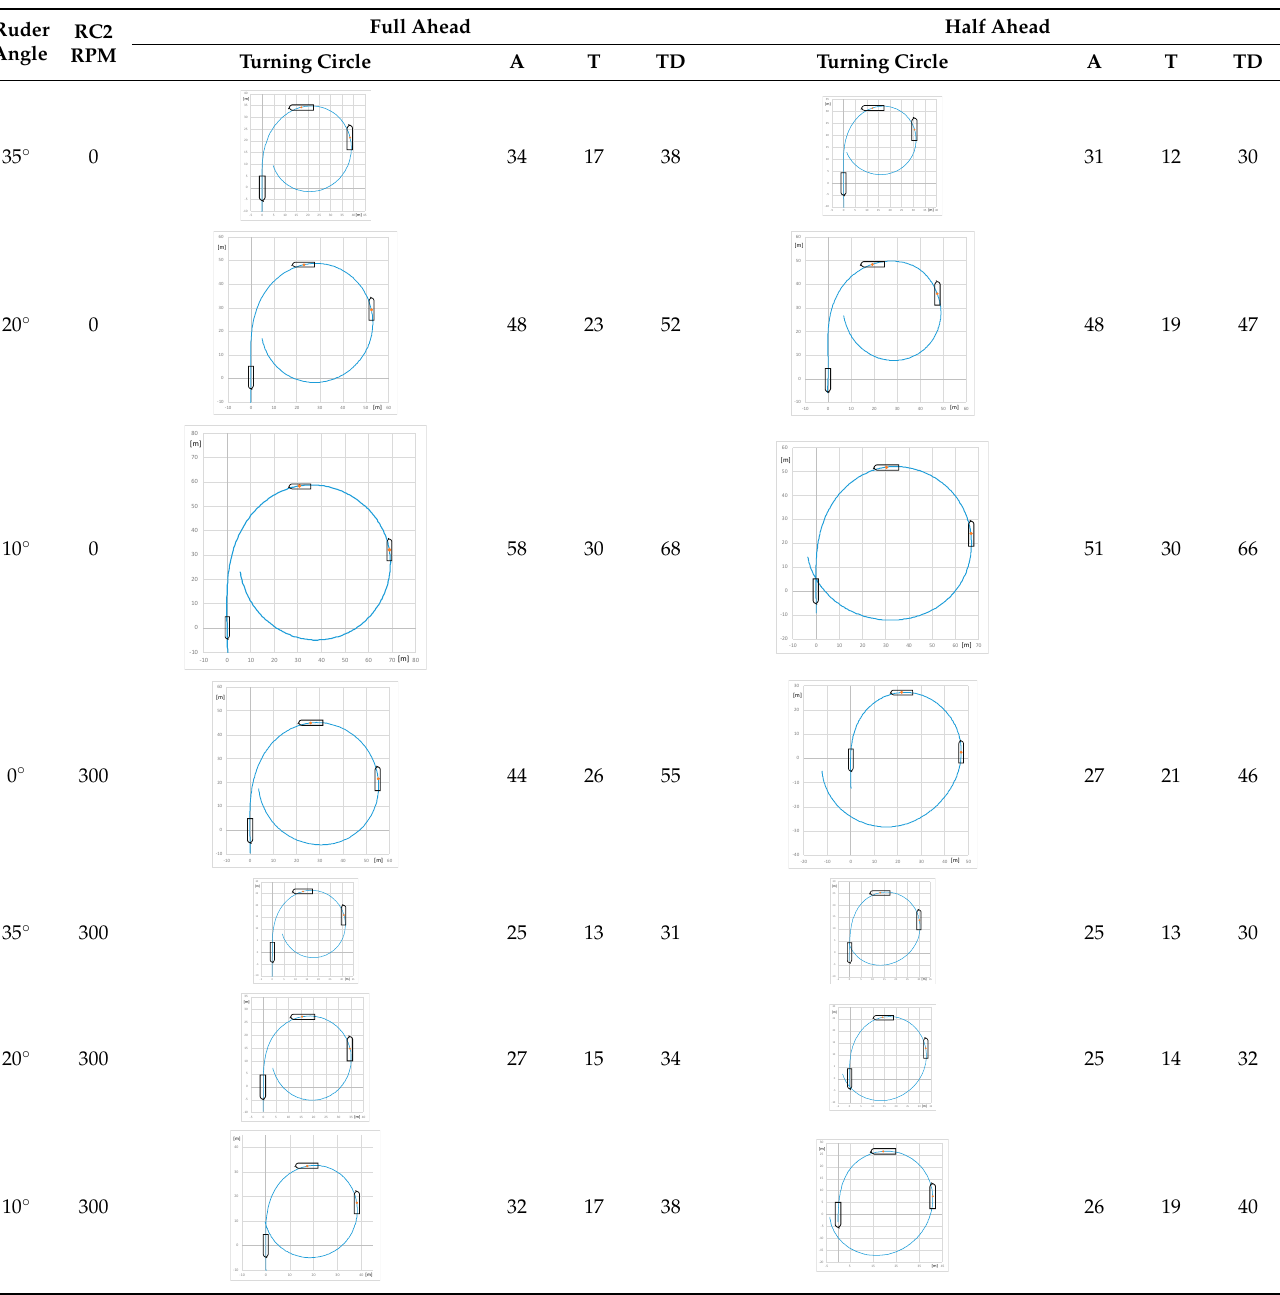
Figure 7. Parameters of the turning circle trial: A—advance, T—transfer, DT—tactical diameter. Table 7. Turning circle trial at Full Ahead and Half Ahead engine settings, rudder angles set to starboard, and clockwise rotation of RC2.